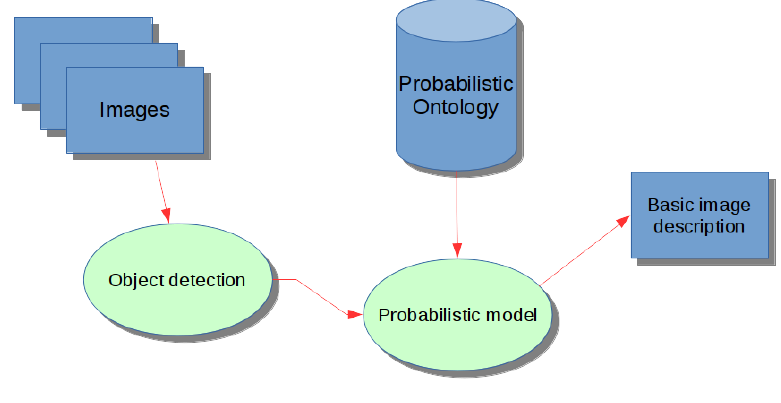
Figure 1. Scheme of the proposed